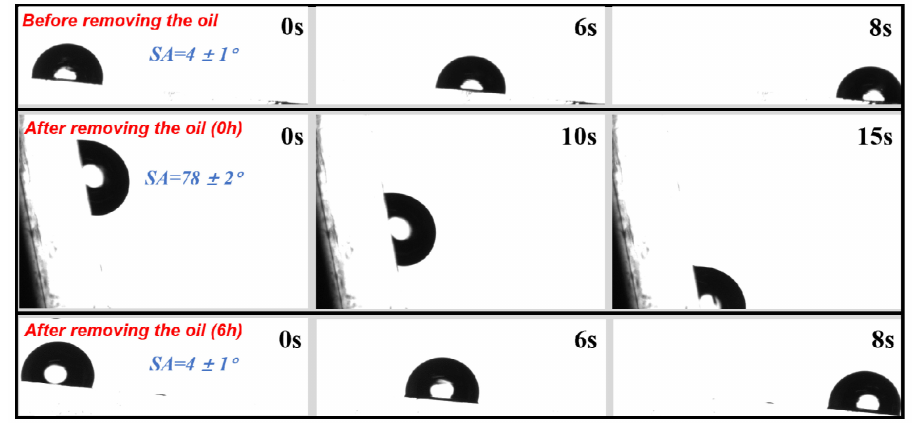
Figure 7. Sliding angles of the 1P1S sample before and after removing the oil from the surface.